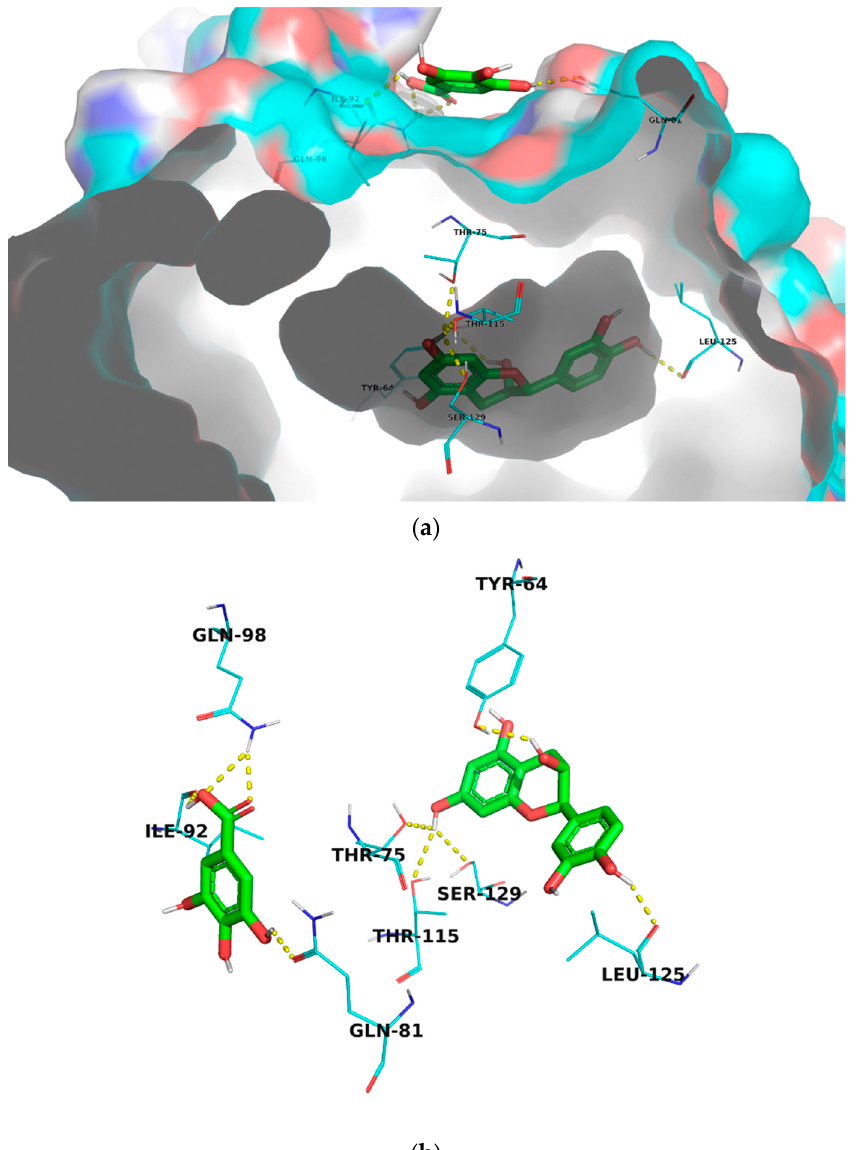
Figure 6. Molecular model binding of simultaneously docked catechin and gallic acid to the tran- scriptional activator receptor ( Las R, PDB code: 2UVO); ( a ) Las R protein in surface presentation demonstrating the docking sites of catechin and gallic acid ( b ) Line presentation of Las R amino acid residues involved in interaction with catechin and gallic acid.